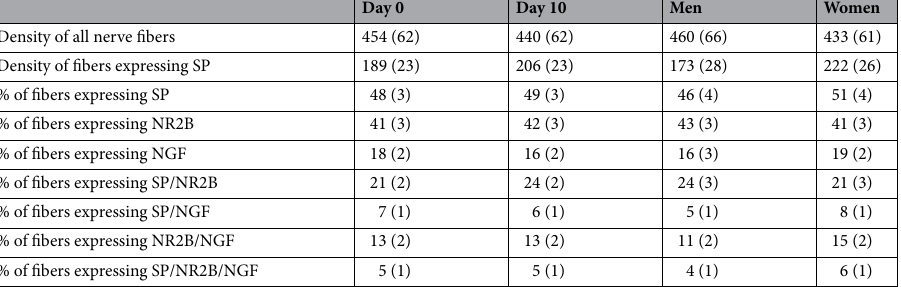
Table 3. The density and expression of nerve fibers within connective tissue. The table presents the mean (SEM) of nerve fibers density (fibers/area on mm 2 ), the density of fibers expressing SP (putative afferent fibers) and the frequency (%) of nerve fibers expressing markers alone and in combination on day 0 and 10 as well as from men and